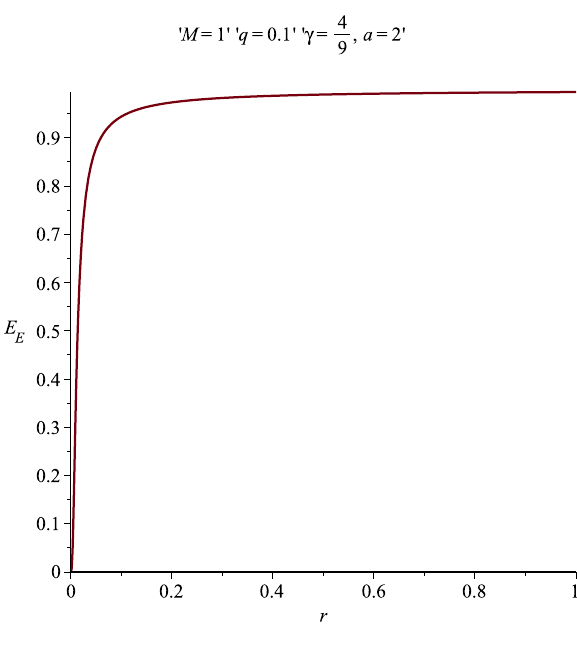
Figure 1. Einstein energy versus the radial distance r .